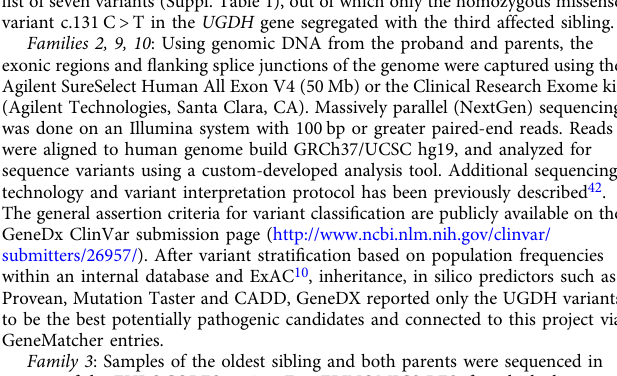
Fig. 4 Patient-derived cerebral organoids are underdeveloped. a Volumes (mean ± SD) and b representative images (scale bar = 1 mm) of cerebral organoids derived from iPSCs from WT ( n = 18 organoids from the same batch), unaffected parent ( UGDH WT/A82T, n = 15), and patients ( UGDH A82T/ A82T ( n = 10), Y14C/S72P ( n = 7), and R65*/Y367C ( n = 6) after 10 weeks of differentiation. Lower right panel: close-up views of the edges of indicated cerebral organoids. Scale bar = 500 μ m. c RT-qPCR for neuronal differentiation markers ( PAX6 , TBR2 , and TUJ1 ) in WT ( n = 4 cerebral organoids), unaffected parent (WT/A82T, n = 3), and patients (A82T/A82T, Y14C/S72P, and R65*/Y367C, n = 3 each) cerebral organoids. Levels of expression are normalized to GAPDH . Mean± SD fold change relative to WT is plotted. d Representative images of consecutive sections of cerebral organoids derived from iPSCs from WT ( N = 5 cerebral organoids, n = 40 ventricle-like zones), unaffected parent (WT/A82T, N = 4, n = 15), and patients (A82T/A82T N = 3, n = 40, Y14C/S72P N = 4, n = 18, and R65*/Y367C N = 2, n = 9) stained with H&E, and immunostained with markers TUJ1/PCNA/DAPI,